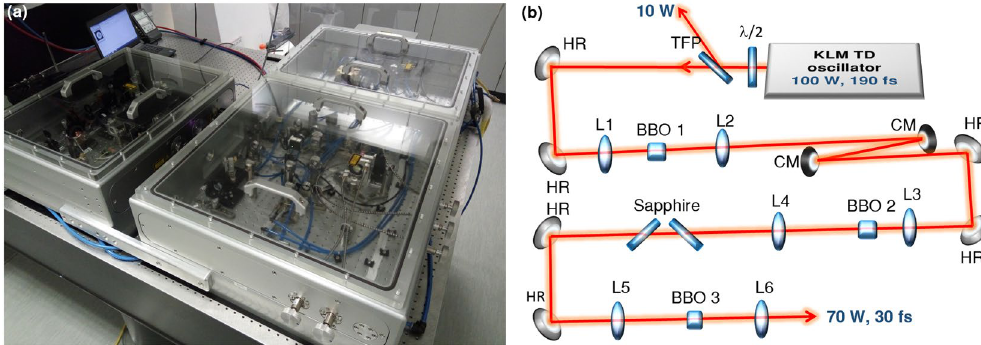
Figure 1. ( a ) Photo of oscillator and compression chamber. The larger housing contains the KLM TD oscillator. The smaller housing contains the compression setup which is sketched in ( b ) The power sent to the BBO crystals was controlled by the half-wave plate ( λ /2) and the thin-film polarizer (TFP). The beam was steered by pairs of 45° highly reflective dielectric mirrors (HR). All lenses (L1-L6) were plano-convex, anti-reflection (AR) coated fused-silica lenses. The chirped mirrors (CM) exhibited a group delay dispersion (GDD) of + 2000 fs 2 . The two sapphire plates were 5 mm thick and placed at Brewster’s angle. The BBO crystals were mounted on a translation stage and could be rotated in the vertical direction for the purpose of angle-tuning. BBO 1 and BBO 2 were 10 mm long and BBO 3 6 mm. The apertures were 7 × 7 mm 2